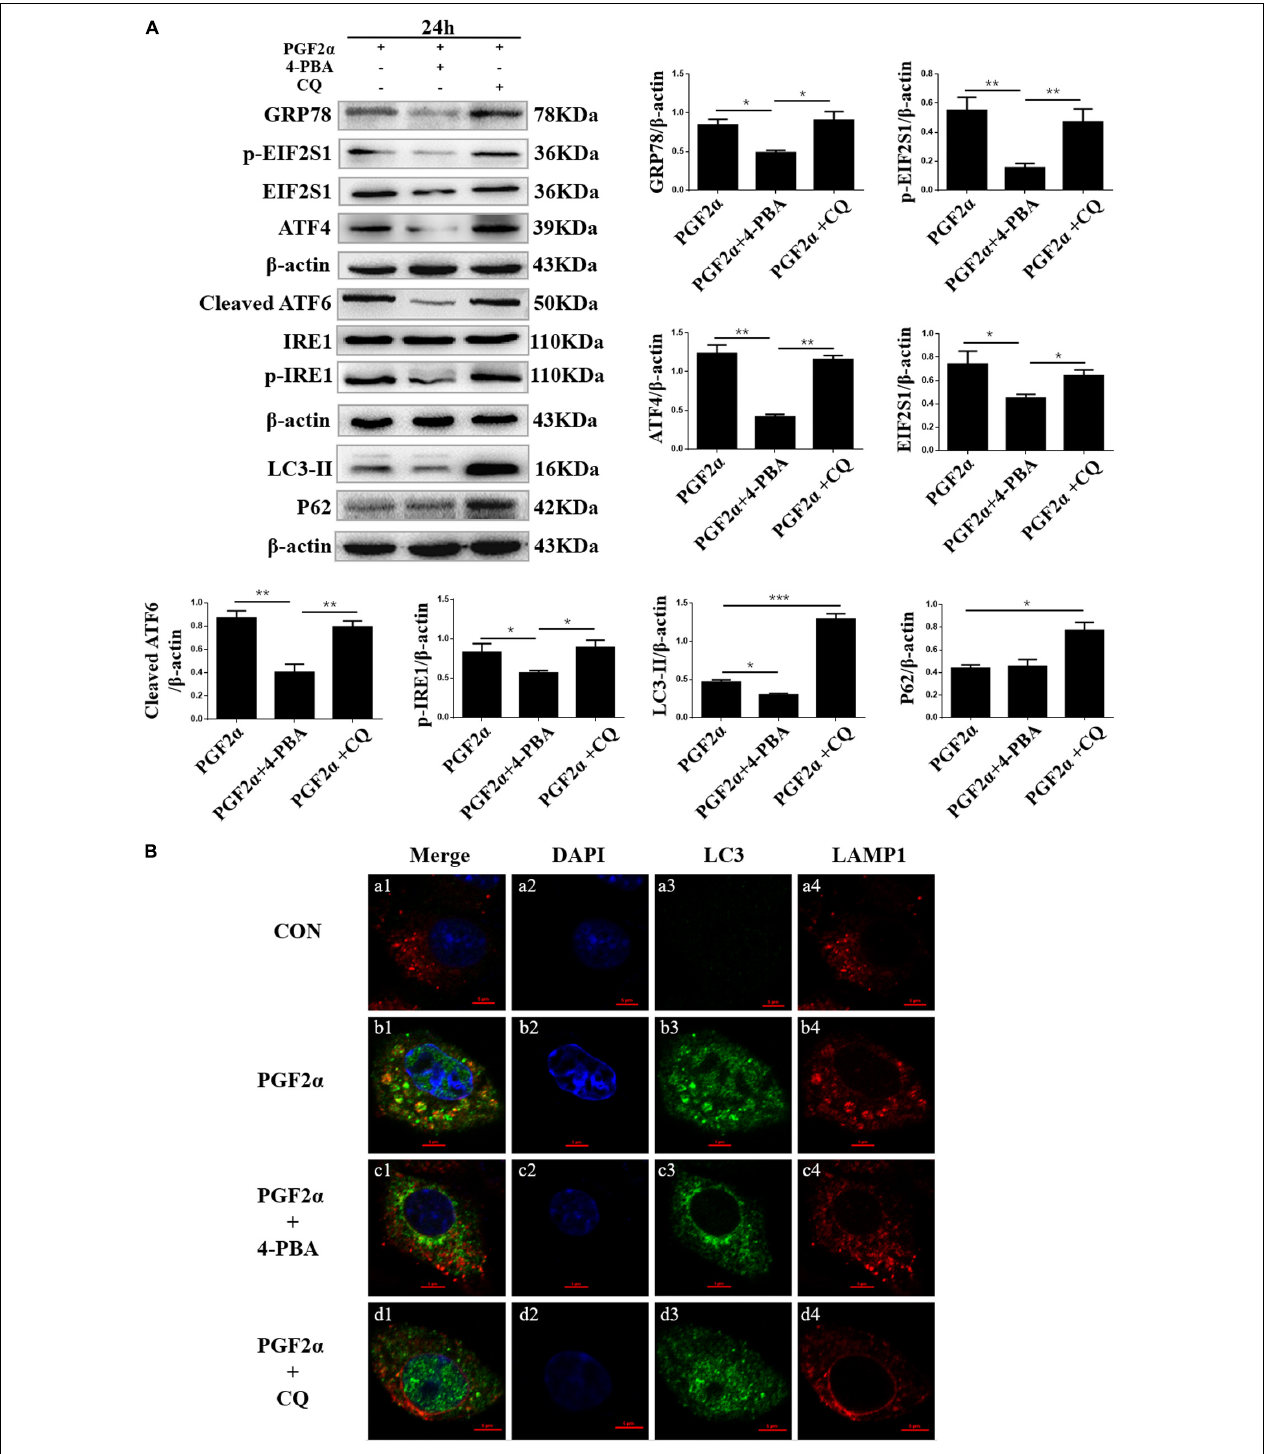
FIGURE 4 | Effect of 4-PBA and CQ on ER stress and autophagy under PGF2 α treatment. (A) Cells cultured in medium with PGF2 α (1 µ M), PGF2 α (1 µ M), and 4-PBA (1 µ M) to inhibit ERS or PGF2 α (1 µ M) and CQ (100 µ M) to inhibit autophagy for 24 h. The expression of IRE1, GRP78, ATF6, ATF4, cleaved-PARP, LC3, and P62 are detected by western blot analysis. Data in the bar graph represent the mean ± SEM of three independent experiments ( N = 3). Means compared with one-way ANOVA combined with Tukey’s post hoc tests. * p < 0.05, ** p < 0.01, *** p < 0.001 compared to PGF2 α group. (B) Confocal microscopy images of LC3 and LAMP1 expression in the goat luteal cells which are treated with PBS, PGF2 α (1 µ M), PGF2 α (1 µ M), and 4-PBA (1 µ M) or PGF2 α (1 µ M) and CQ (100 µ M). Scale bar = 5 µ m.